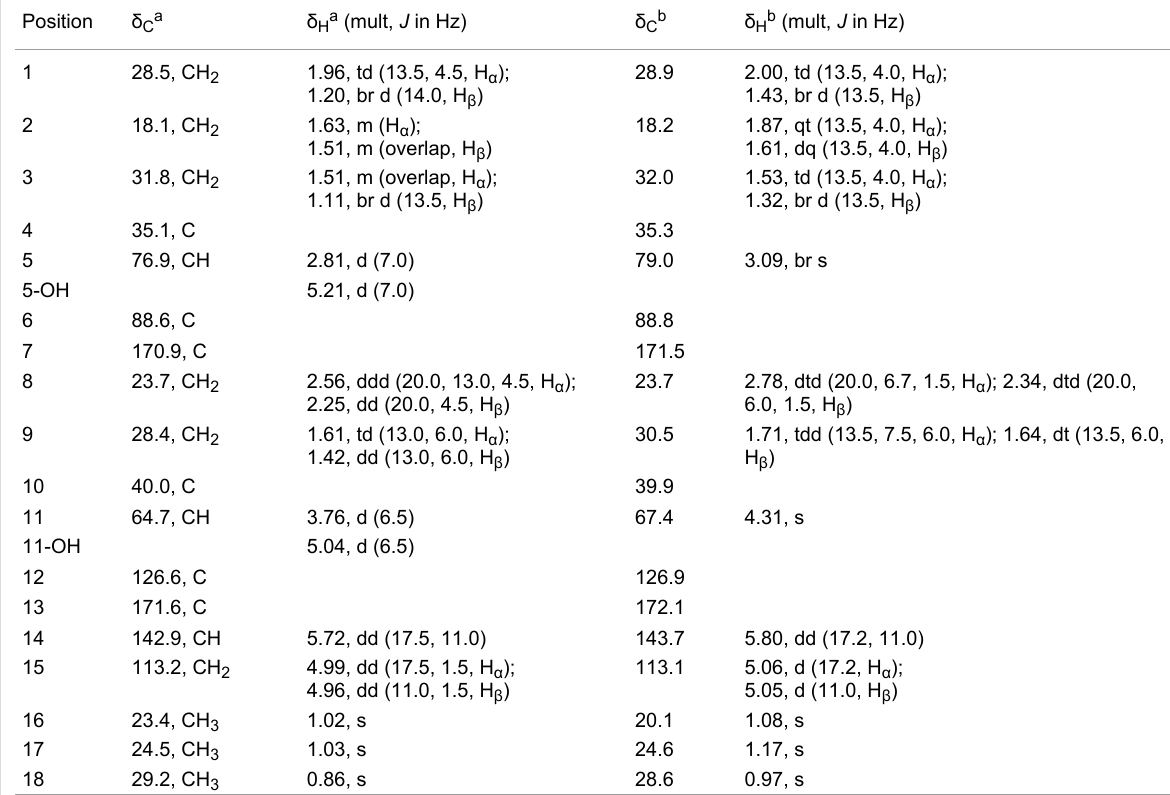
Table 1: 1 H and 13 C NMR spectroscopic data for aspergiloid I ( 1 ).